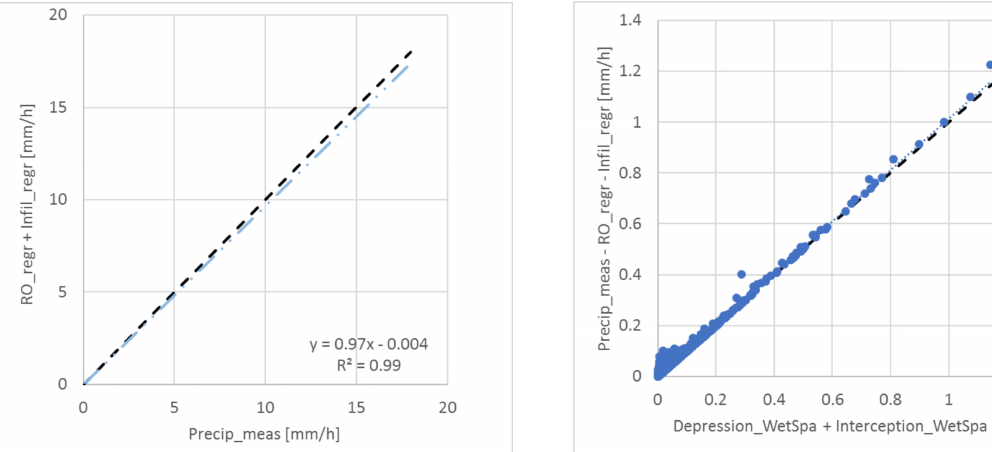
Figure 7. The water balance for the Watermaelbeek (WMB) catchment. ( a ) Water balance without interception and depression storage (precipitation vs. the regressed surface runoff and infiltration averaged over the WMB catchment) and ( b ) validation of estimated interception and depression storage from the regression (precipitation minus the regressed surface runoff and infiltration) with the WetSpa